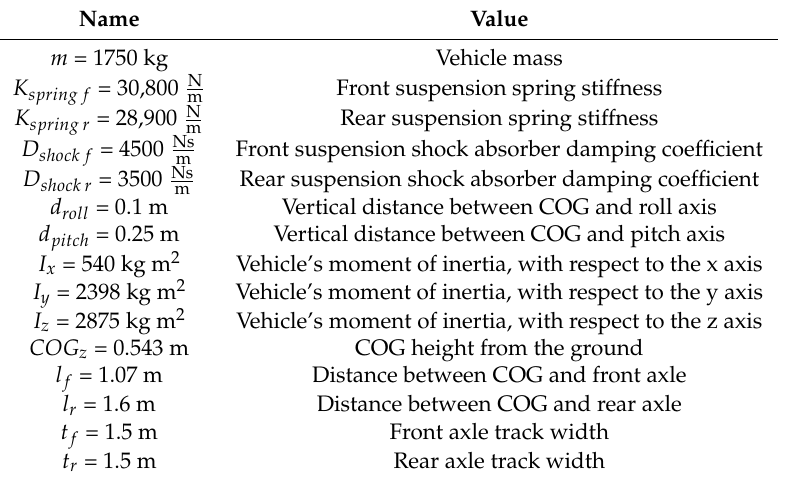
Table 1. Model parameters (chassis, tires, and